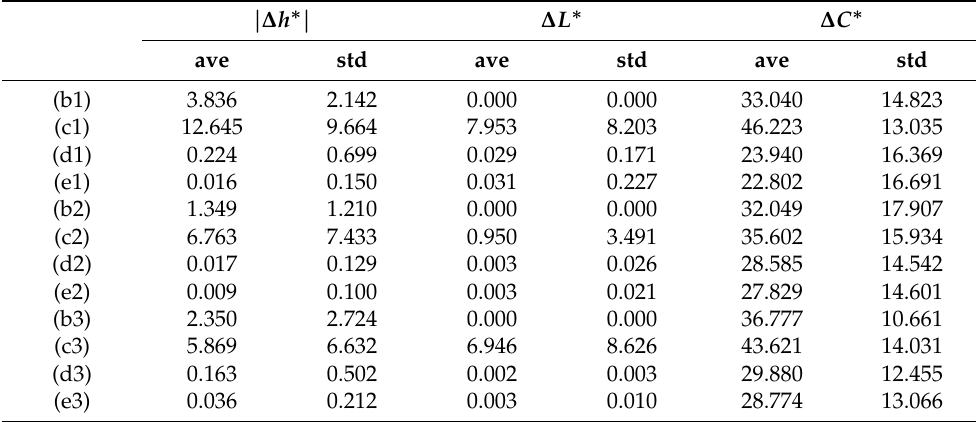
Figure A2. Experimental results. ( a1 , a2 ) Original images. Output images by ( b1 , b2 ) chroma and lightness enhancement (RGB, γ = 10, histogram equalization), ( c1 , c2 ) the method of Ref. [5] using histogram equalization, ( d1 , d2 ) the method of Ref. [7] using default parameters, ( e1 , e2 ) chroma and lightness enhancement (CIELAB, k = 5, p = 1.5), and ( f1 , f2 ) chroma and lightness enhancement (CIELAB, k = 5, p = 1.5) and color gamut adjustment by the lookup table. ( a3 , a4 ) Original images. Output images by ( b3 , b4 ) chroma and lightness enhancement (RGB, γ = 10, histogram equalization), ( c3 , c4 ) the method of Ref. [5] using histogram equalization, ( d3 , d4 ) the method of Ref. [7] using default parameters, ( e3 , e4 ) chroma and lightness enhancement (CIELAB, k = 5, p = 1.5), and ( f3 , f4 ) chroma and lightness enhancement (CIELAB, k = 5, p = 1.5) and color gamut adjustment by the lookup table. Table A1. Averages and standard deviations of | ∆ h ∗ | , ∆ L ∗ , and ∆ C ∗ in Figure